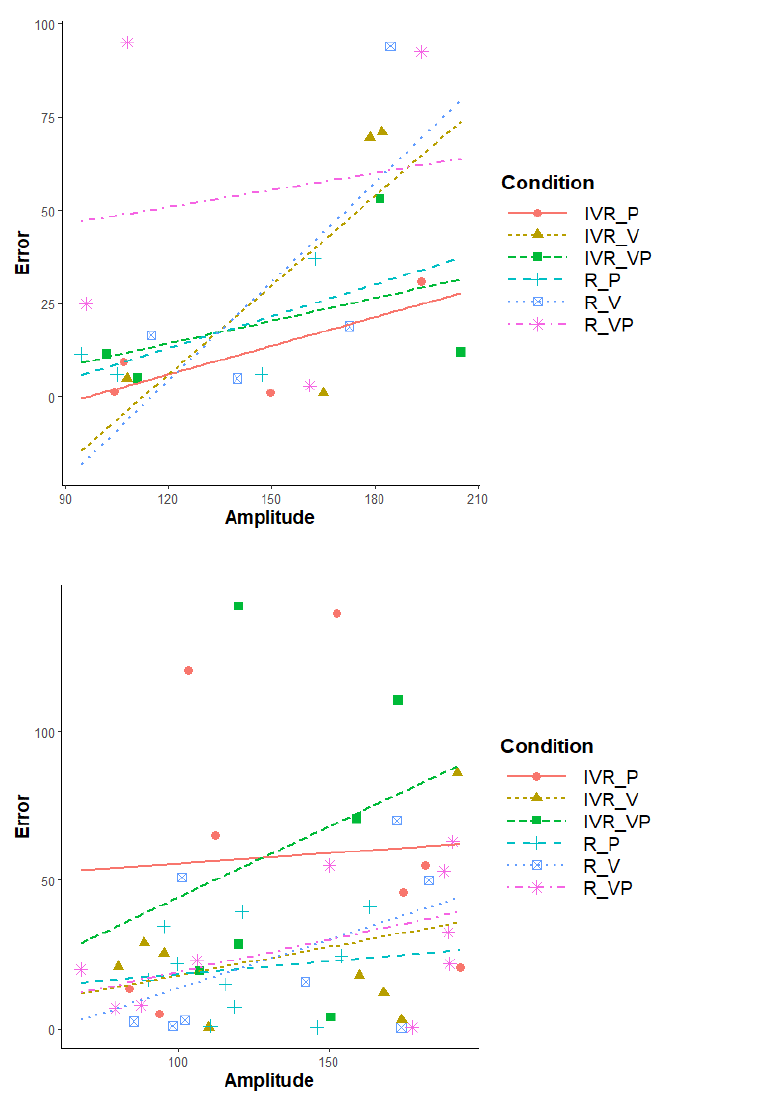
Figure 5. ( a ) Regression lines of self-turn error according to rotation amplitude in each condition. Children ( n participants = 2; n observations = 24). ( b ) Regression lines of self-turn error according to rotation amplitude in each condition. Adults ( n participants = 5; n observations = 50).